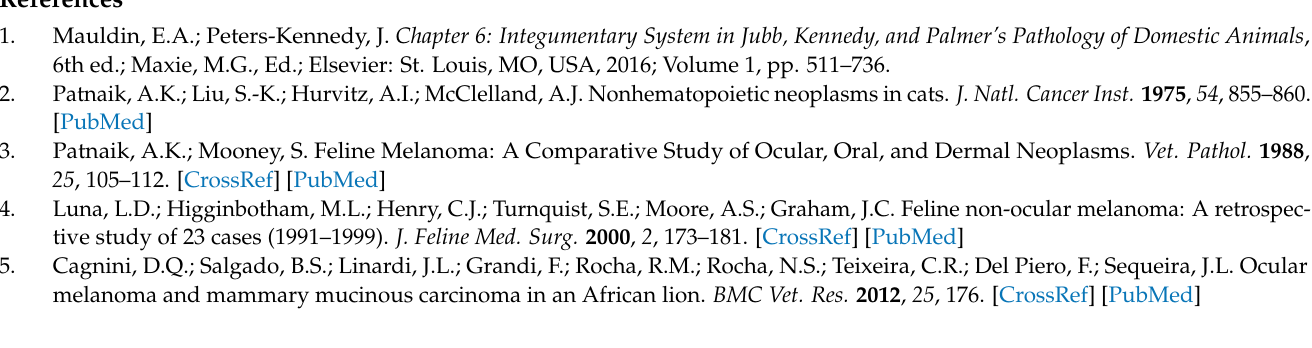
S2: Diagnostic serum chemistry laboratory report for the lioness, Table S3: Diagnostic viral screen laboratory report for the